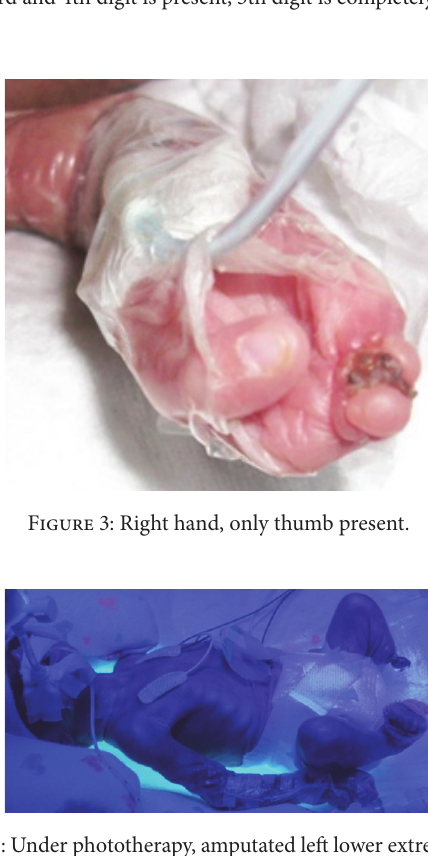
Figure1:Lefthand:newbornwithvisiblebandstetheringfingerstogether.Amnioticbandshaveresultedinsyndactyly,amputation,adhesion, and band indentation. Thumb and index finger are intact; only proximal part of 3rd and 4th digit is present; 5th digit is completely missing.